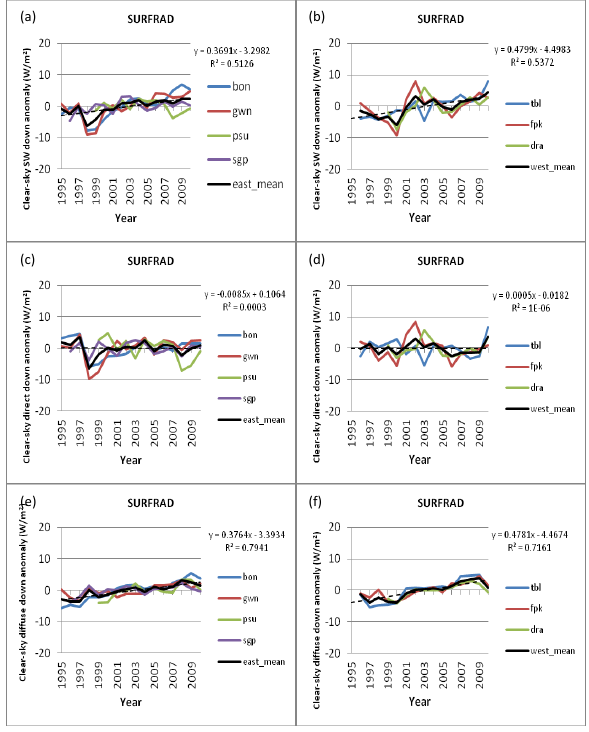
Figure 9: Annual anomalies of clear-sky downwelling SW (first row), direct SW (second row) 4 Fig. 9. Annual anomalies of clear-sky downwelling SW (first and diffuse SW (third row) from SURFRAD for each site (colored line) and the network mean 5 row), direct SW (second row) and diffuse SW (third row) from (solid black line) together with the LSF (dash black line) to the network mean. The best-fit 6 SURFRAD for each site (colored line) and the network mean (solid equation and coefficient of determination (R 2 ) are given at right in each panel. The left 7 black line) together with the LSF (dash black line) to the network column represent eastern US while the right column represent western US 8 mean. The best-fit equation and coefficient of determination ( R 2 ) are given at right in each panel. The left column represents eastern US while the right column represents western